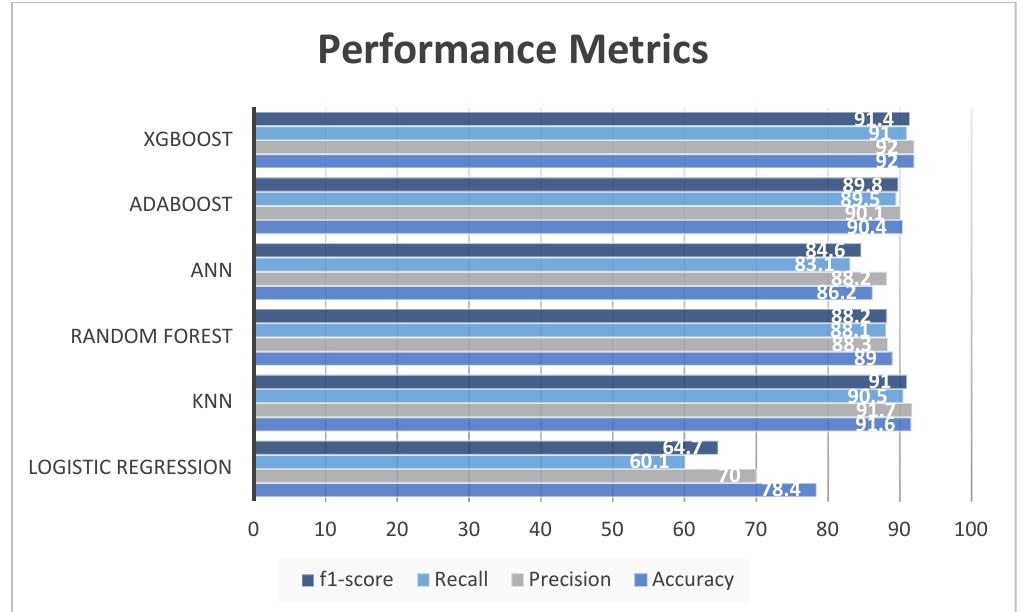
Figure 9. Performance metrics of all the classifiers during the testing phase.